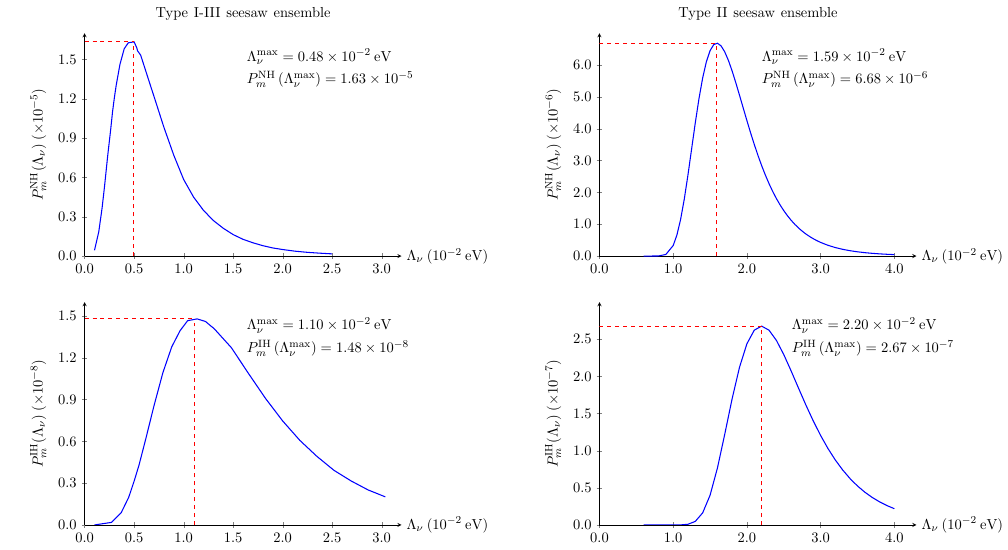
Figure 7 . Probability test for the singular values of the complex seesaw ensembles with N = 3. The left and right columns show the probability distribution as a function of (cid:3) (cid:23) (in the normal and inverted hierarchy scenarios) for the type I-III and the type II seesaw mechanisms